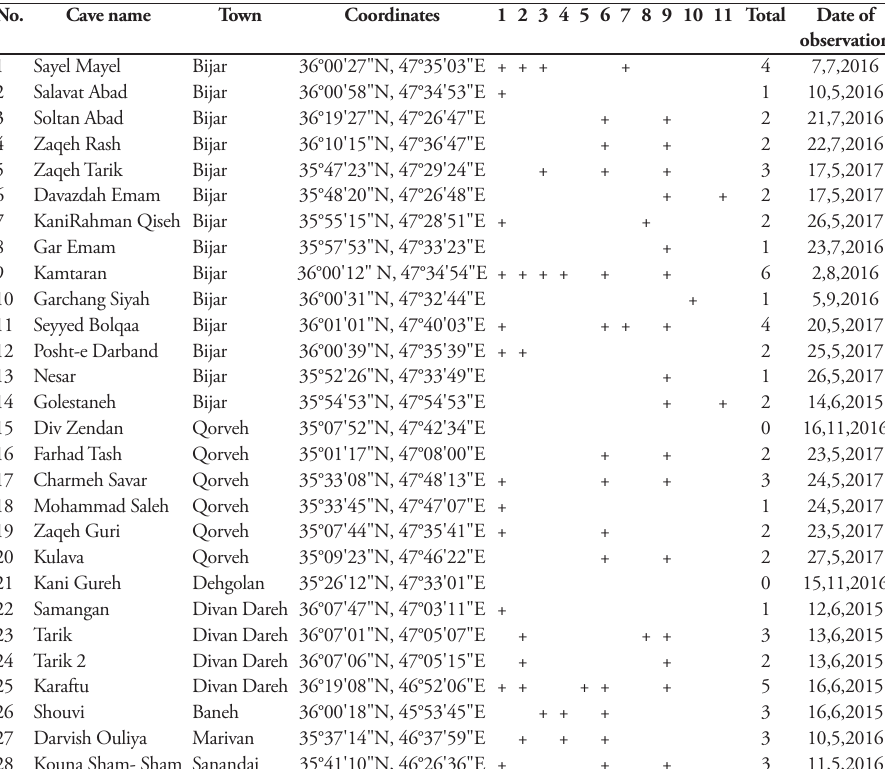
Table 1. The list of 28 caves investigated in Kurdistan Province, with closest town and geographic co- ordinates of the cave entrances. If a bat was recorded, a plus sign is given. Species names are coded with numbers: 1 – Rhinolophus ferrumequinum , 2 – R. mehelyi , 3 – R. euryale , 4 – R. blasii , 5 – R. hipposideros